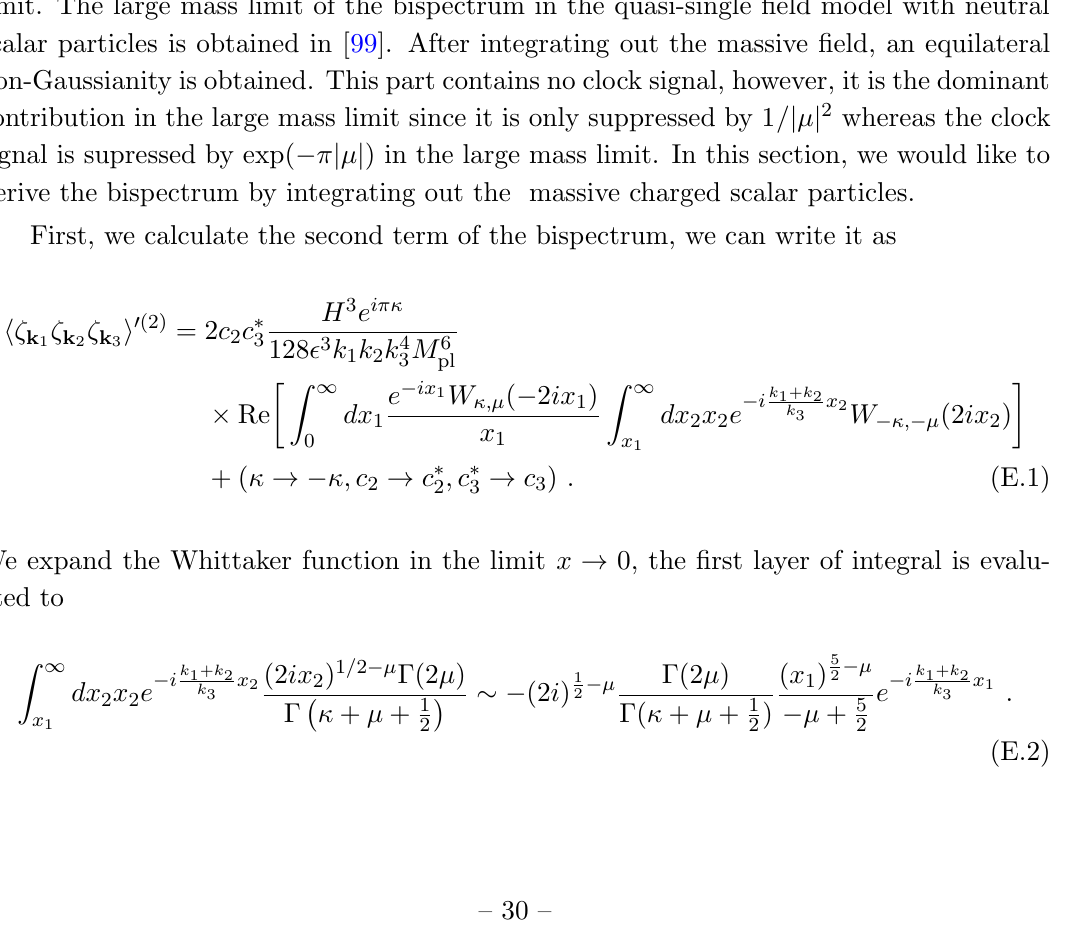
Figure 13 . By setting (cid:20) = i , (cid:22) = 5 i , we can see that the leading order term in I m = 0 ; n = 0 term. This further simpli(cid:12)es our calculation for the power